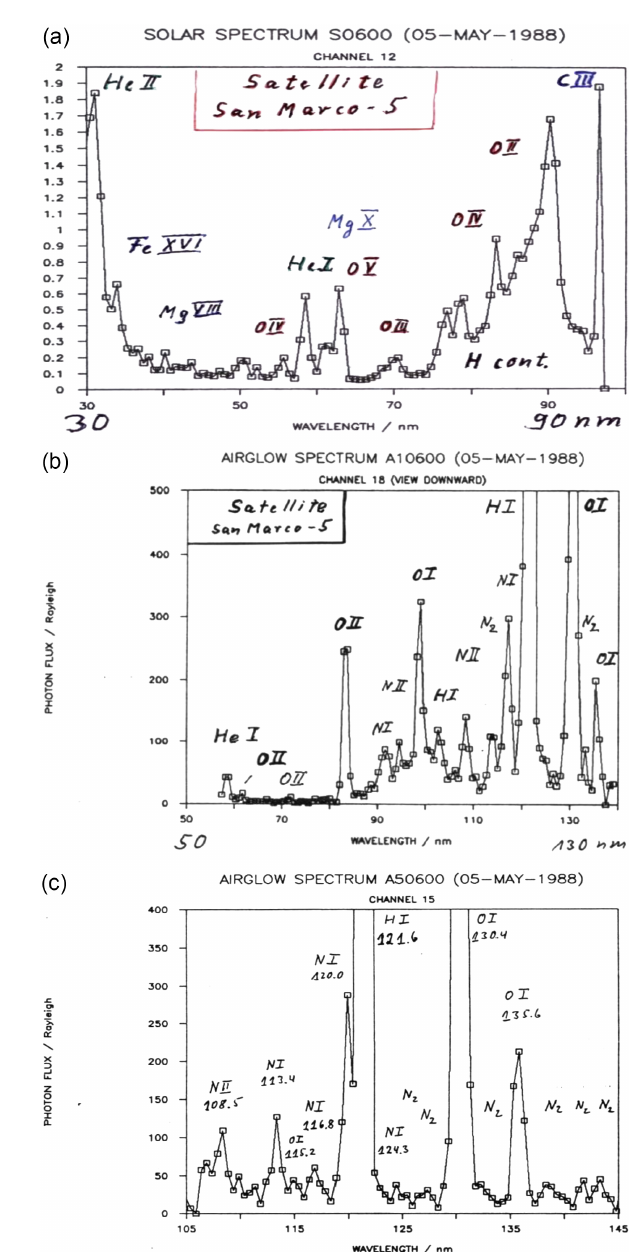
Figure 24. (a) Solar EUV fluxes in 10 10 photons m − 2 s − 1 (Schmidtke et al., 1991; copyright permission granted by Elsevier publishing). (b) Terrestrial airglow EUV fluxes (Rayleigh units) in the equatorial region recorded in Channel 18 (Schmidtke et al., 1991; copyright permission granted by Elsevier publishing). (c) Ter- restrial airglow EUV fluxes (Rayleigh units) in the equatorial region recorded in Channel 15 (Schmidtke et al., 1991; copyright permis- sion granted by Elsevier publishing).